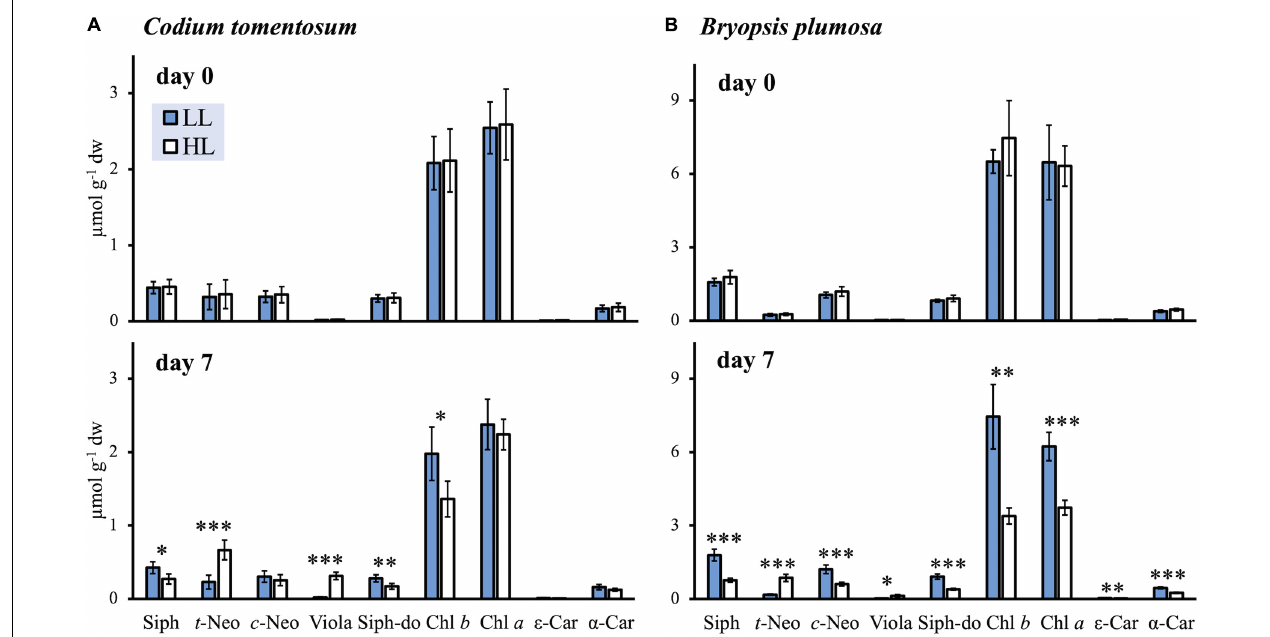
FIGURE 1 | Pigment concentrations of low light (LL) and high light (HL) acclimated macroalgae at the beginning (day 0) and at the end (day 7) of the light acclimation (mean ± SD; n = 5). (A) Codium tomentosum ; (B) Bryopsis plumosa . Asterisks indicate significant differences between LL and HL ( t -tests): ∗ p < 0.05; ∗∗ p < 0.01; ∗∗∗ p < 0.001. For pigment abbreviations see Table 1